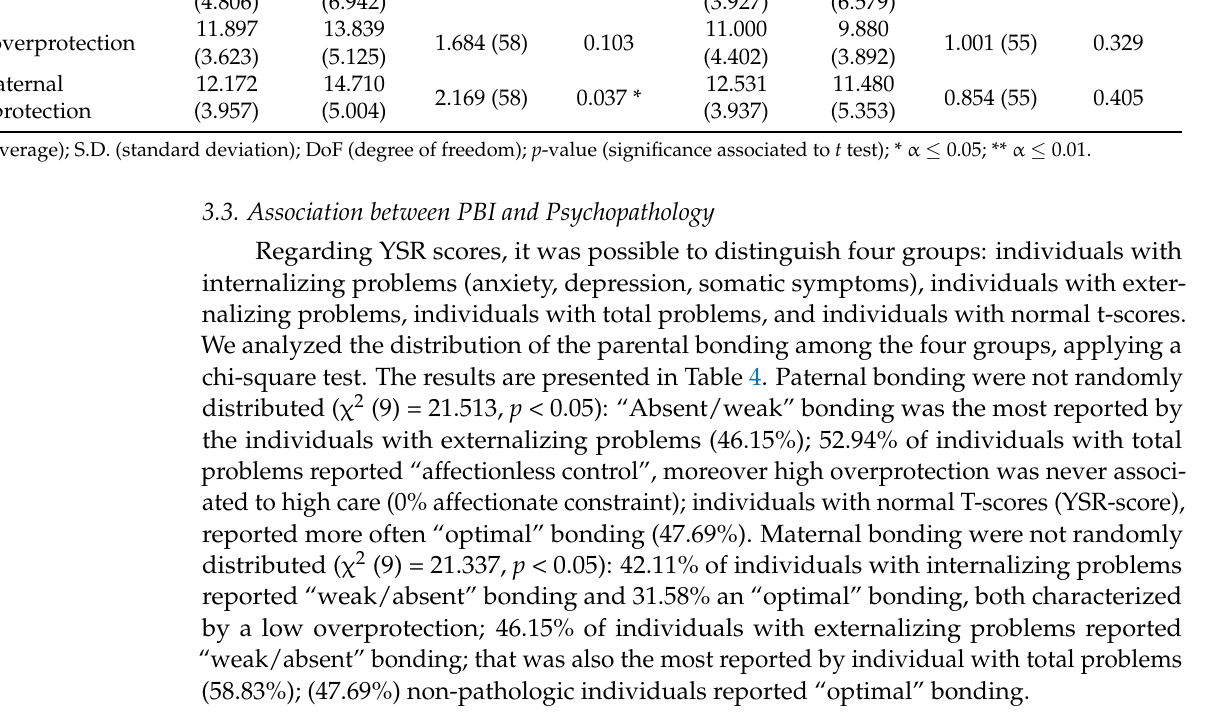
Table 4. Chi-square test based on YSR